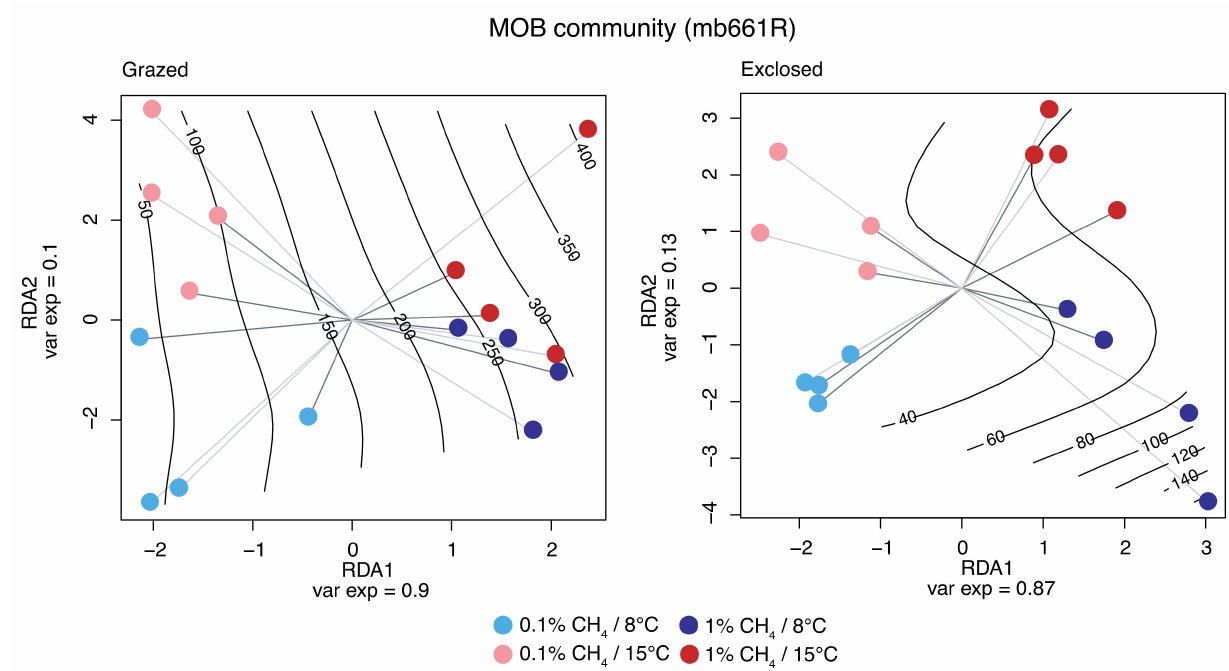
Figure 5. Redundancy analysis of the effect of CH 4 concentration and temperature on the MOB communities after incubation ( pmoA transcripts using the A189F/mb661R primer pair). The effect of CH 4 concentration and temperature was corrected according to the peat block replicates (represented by gray shaded lines). Samples are labeled according to CH 4 concentration (light colors—0.1% CH 4 , dark colors—1% CH 4 ) and temperature (blue—8 ◦ C and red—15 ◦ C). The black lines indicate a projection of the measured CH 4 oxidation rates ( µ g of CH 4 oxidized per gram dry soil and